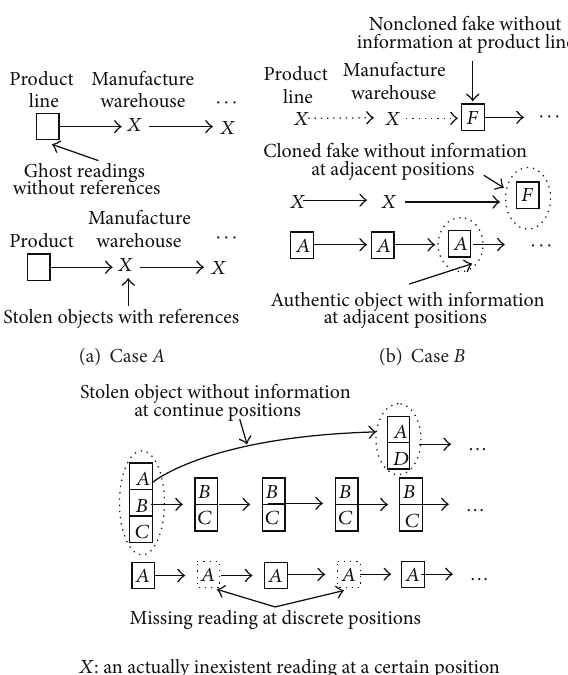
Figure 6: Three special cases for distinguishing ghost, missing, and incomplete data in supply